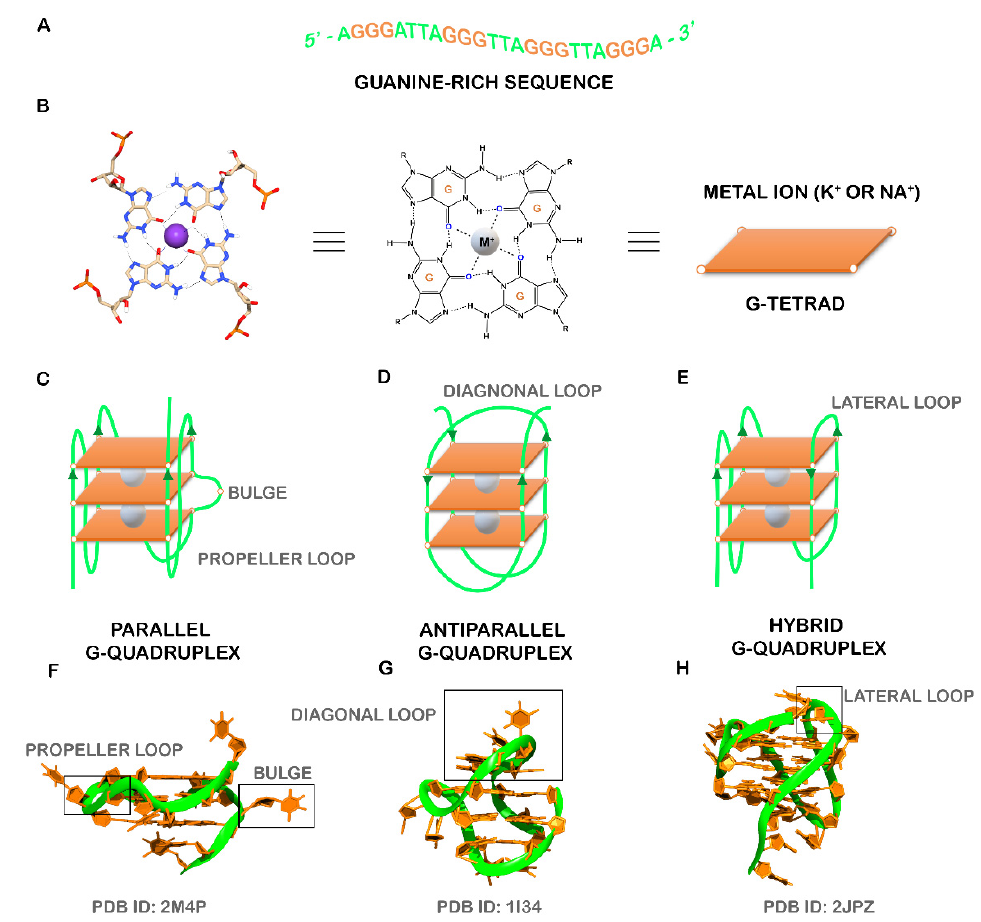
Figure 1. ( A ) Guanine-rich sequence with potential to form a three-tetrad G4. ( B ) Chemical structure of G-tetrad formed by the Hoogsteen hydrogen-bonded guanines and central cation (colored in gray) coordinated to oxygen atoms. Schematic representation of common unimolecular G4s based on the strand direction: ( C ) parallel, ( D ) antiparallel, and ( E ) hybrid. Representative PDB structures of ( F ) parallel (PDB ID: 2M4P), ( G ) antiparallel (PDB ID: 1I34) and ( H ) hybrid (2JPZ) G4 structures. The different loops (propeller, diagonal and lateral) and a bulge were also shown.